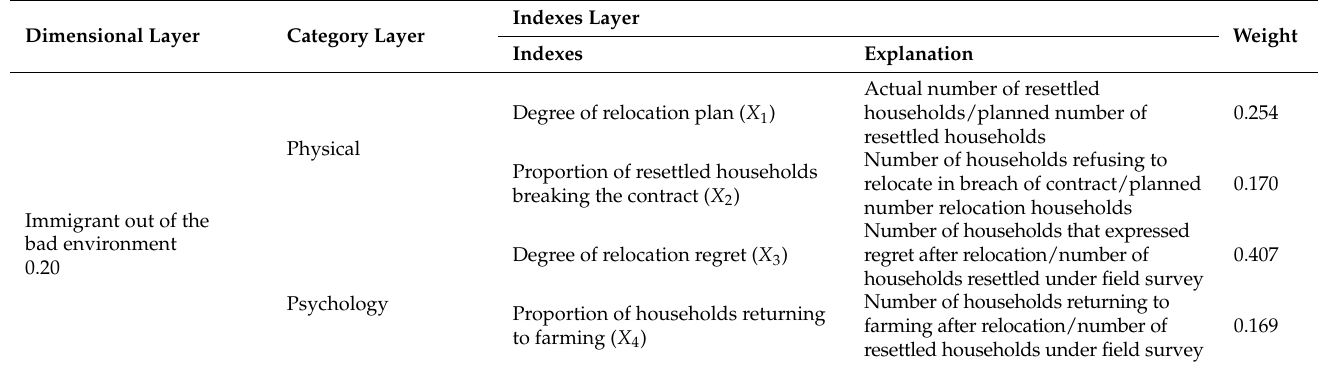
Table 2. Evaluation indexes and their weights of geographical environment adaptation